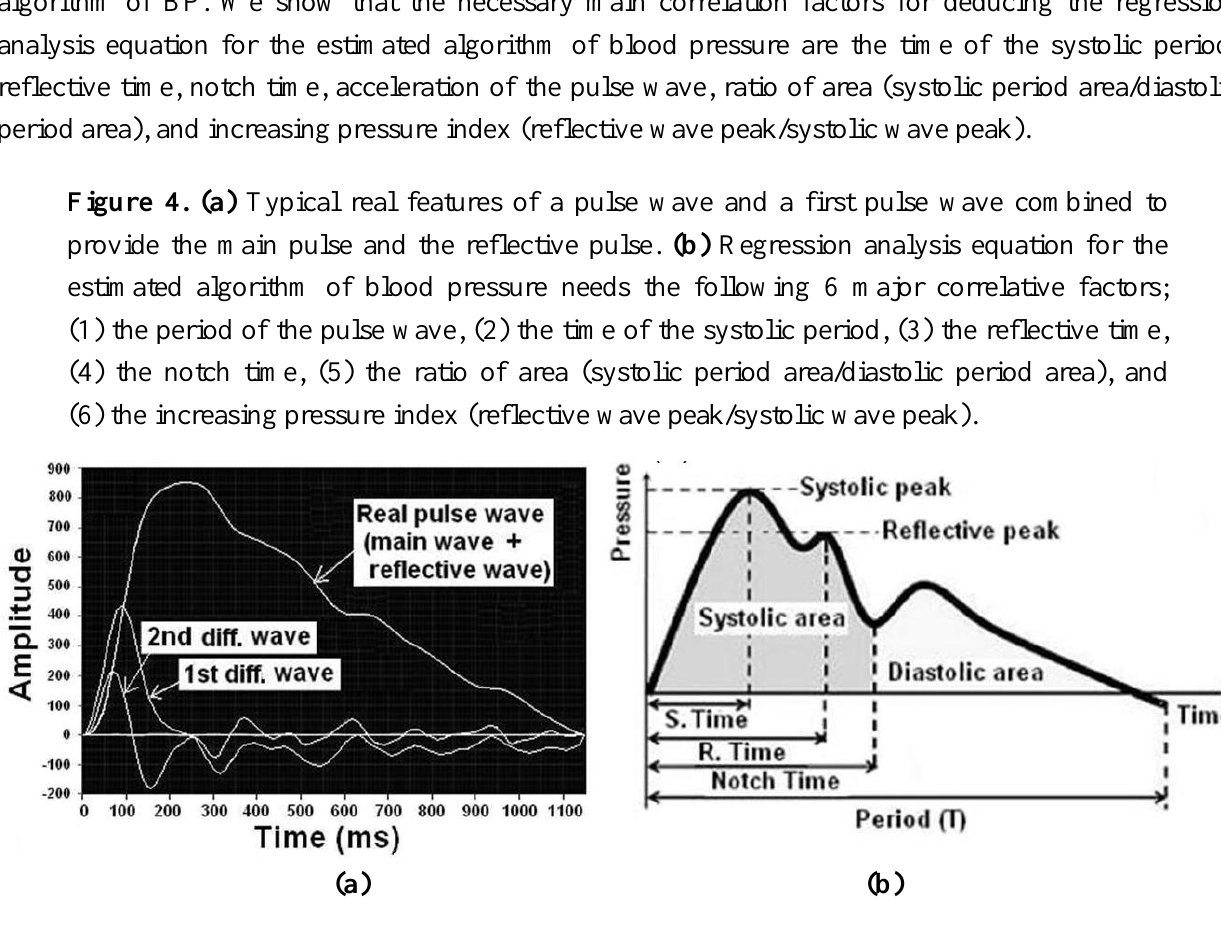
Figure 5. Photographs of the arterial pulsimeter with Hall device in clinical tests. Here the weight and power consumption of the wrist wearable, radial arterial pulsimeter are 80 g and 1.65 W, respectively. The product testing of the proposed arterial pulsimeter and the measuring feature, which are a wristwatch or bracelet, transfer the increased pressure to the skin-contacting part intact when the pressure of the constant pressure chamber is